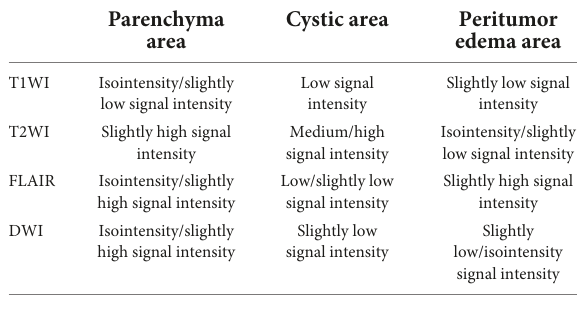
TABLE 2 MRI findings of GL.